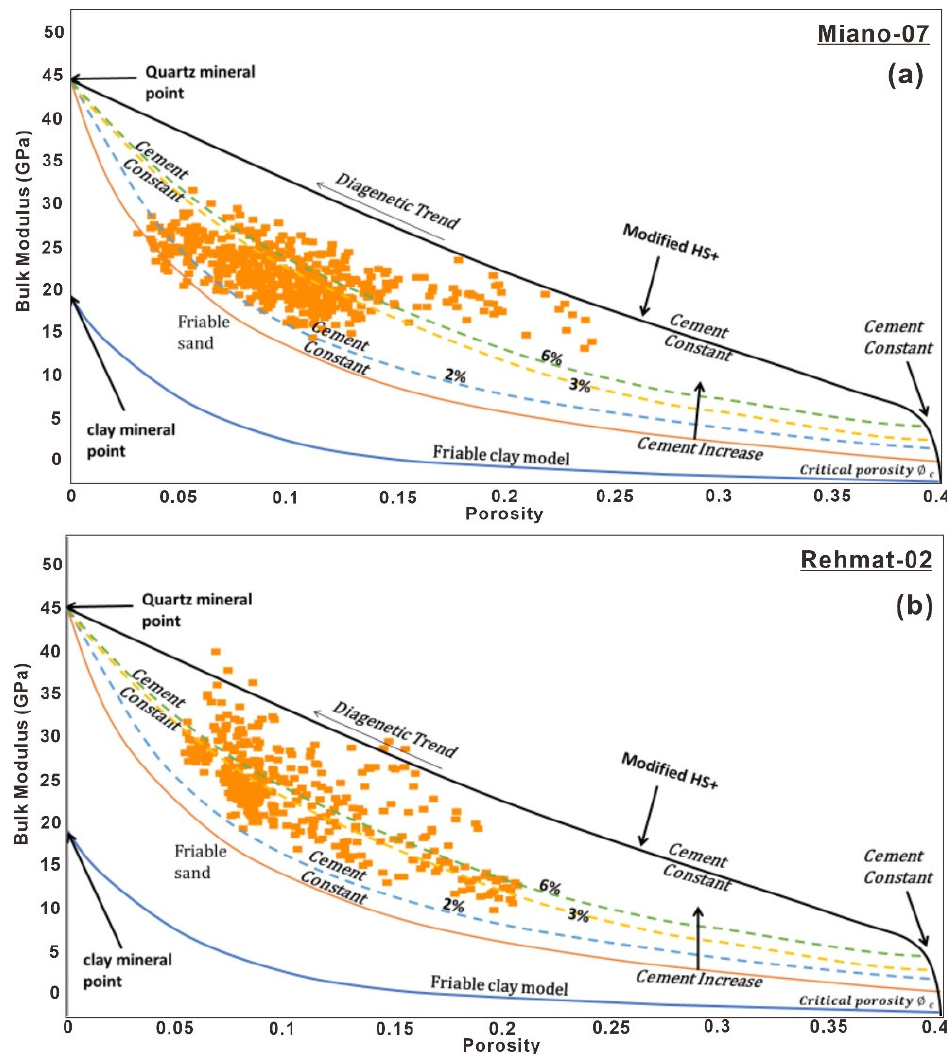
Figure 8. RPD cross-plots of ( a ) Miano-07, and ( b ) Rehmat-02, between Bulk Modulus (K) and porosity of reservoir sands utilizing the CC, CC and FS (uncemented sand) models.